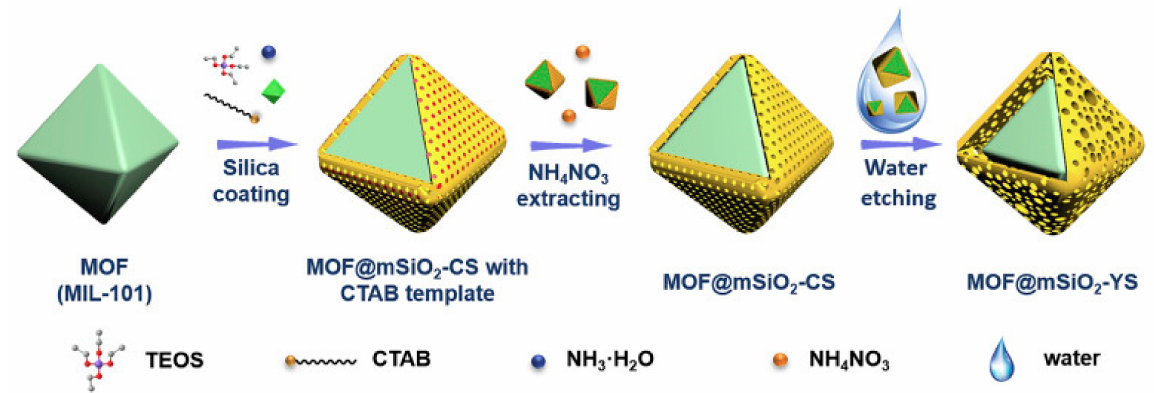
Figure 13. The schematic reaction for the formation of nanoreactors, MOF@mSiO 2 -YS; Step 1: MIL-101(Cr) encapsulation by SiO 2 shell. Step 2: CTAB template removal by extraction give MIL-101@mSiO 2 -CS. Step 3: etching of MIL-101@mSiO 2 -CS using hot water. Reprinted with permission from Ref. [159]. Copyright 2020